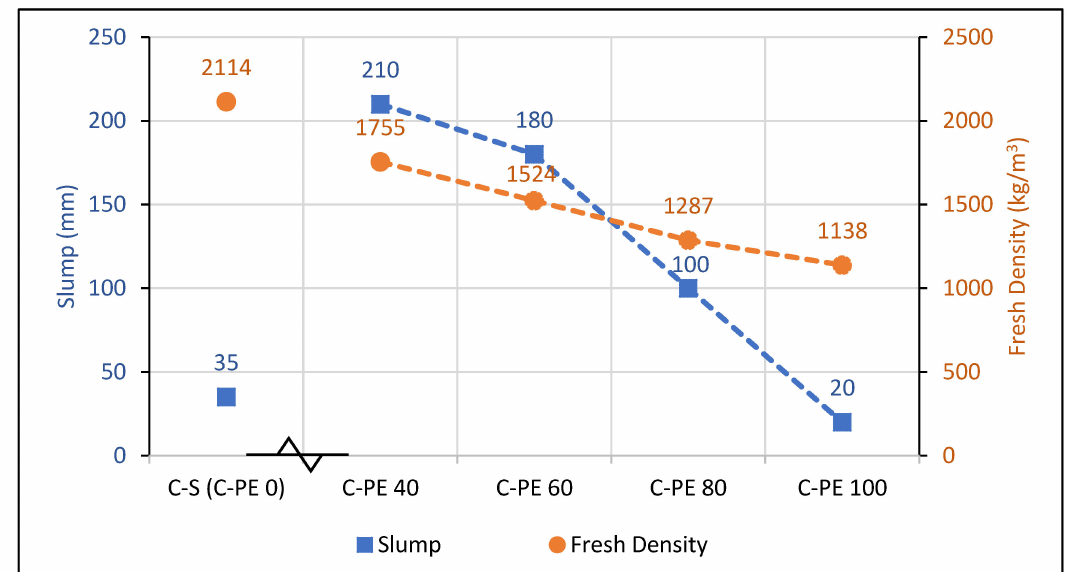
Figure 35. Slump and fresh density of C-S and C-PE